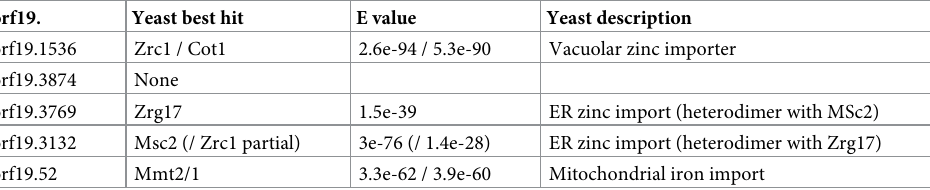
Table 1. Identified ZnT-type transporter in C . albicans and their relationship with S . cerevisiae .